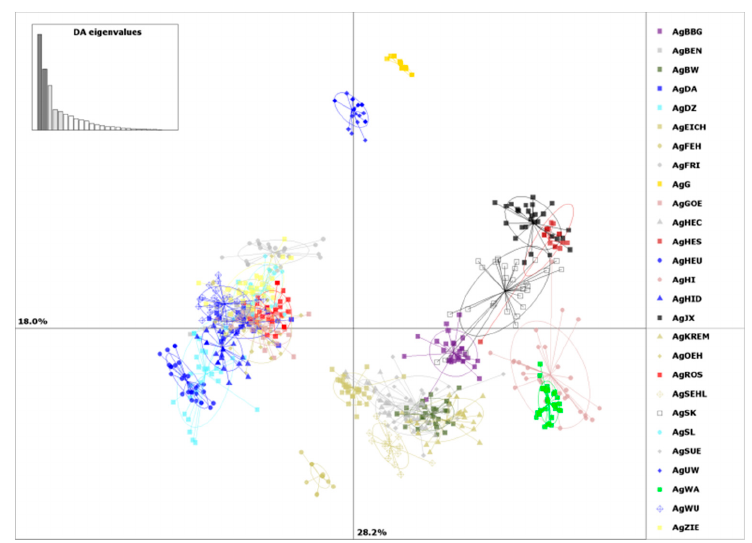
Figure 1. The scatter plot of the Discriminant Analysis of Principal Components (DAPC) shows the genetic structure within the collection of 27 occurrences of A. graveolens ssp . graveolens . Colors refer to the ecogeographic unit where the occurrence was sampled.